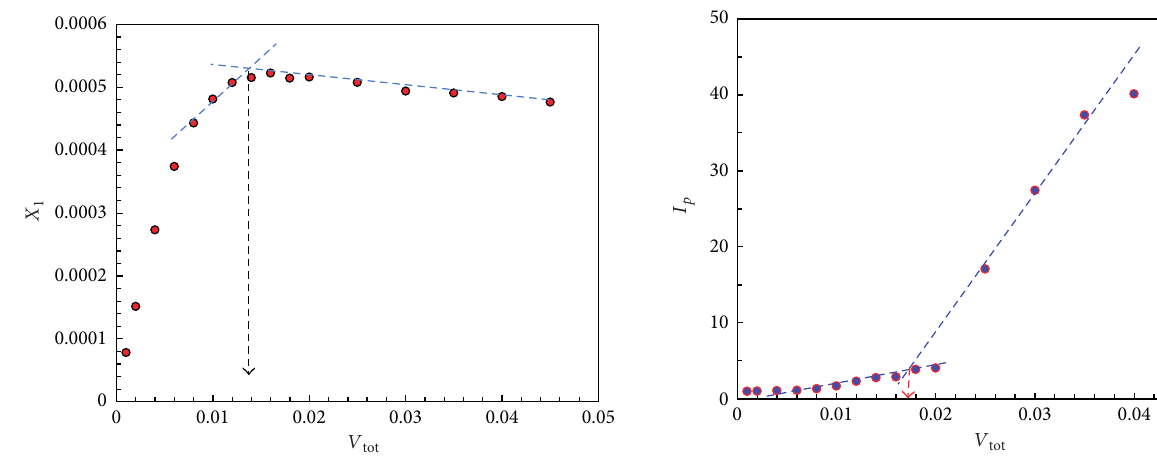
surfactant. is graph is oen used for determination of the CMC.